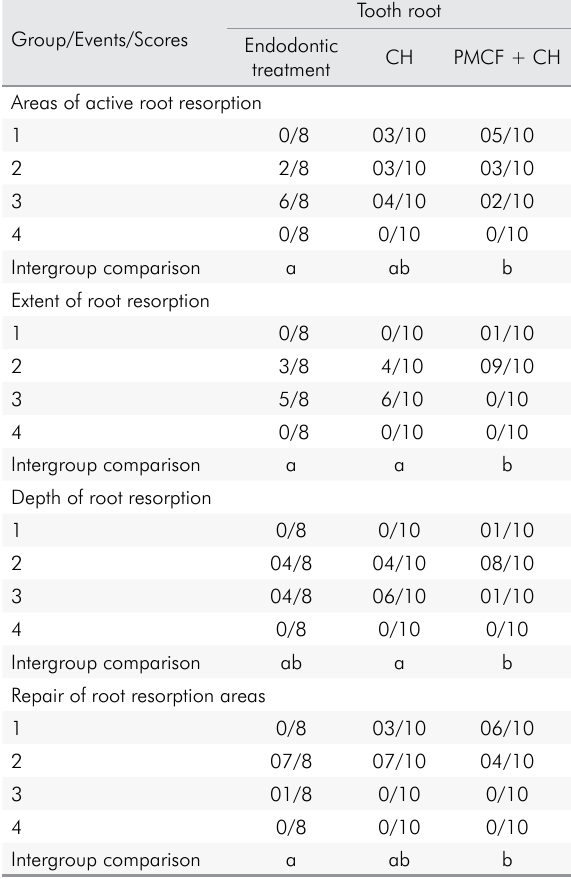
Table 3. Distribution of scores and statistical analysis of the histomorphometric events associated with root dentin resorption (Wilcoxon signed ranks test at 5% significance level).